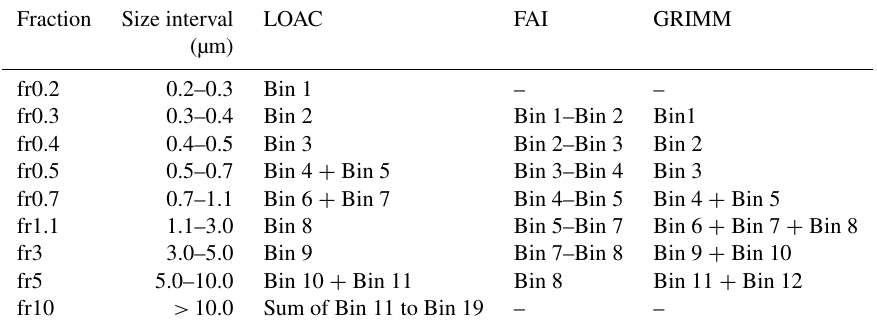
Table 3. Fractions analyzed with the LOAC, FAI, and GRIMM instruments, with the corresponding bin combinations (sums or differences). Fraction Size interval